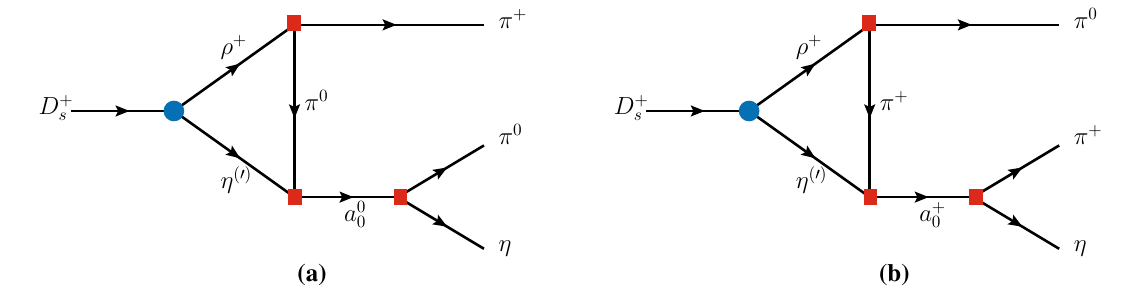
→ )π 0 η and b D + 0